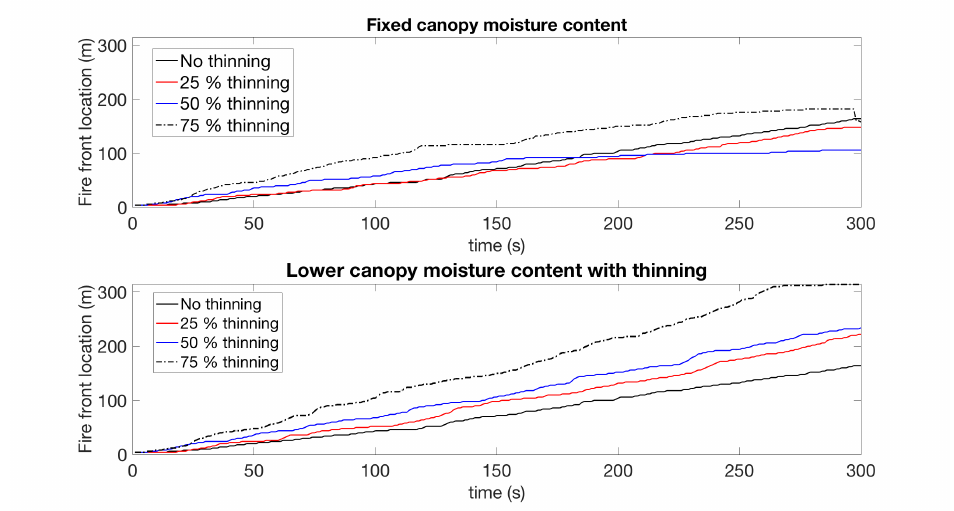
Figure 4. Fire rate of spread for the different simulation cases. Top panel shows the reference case and the three thinning cases with no change of canopy fuel moisture. Bottom panel shows the reference cases and the 3 thinning cases with lower canopy fuel